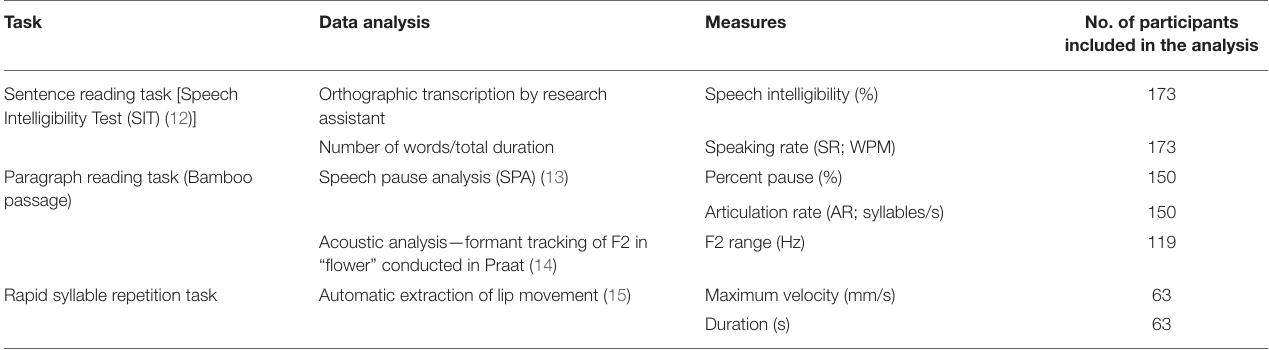
TABLE 1 | Outcome measures derived from each task and number of participants included in each analysis.